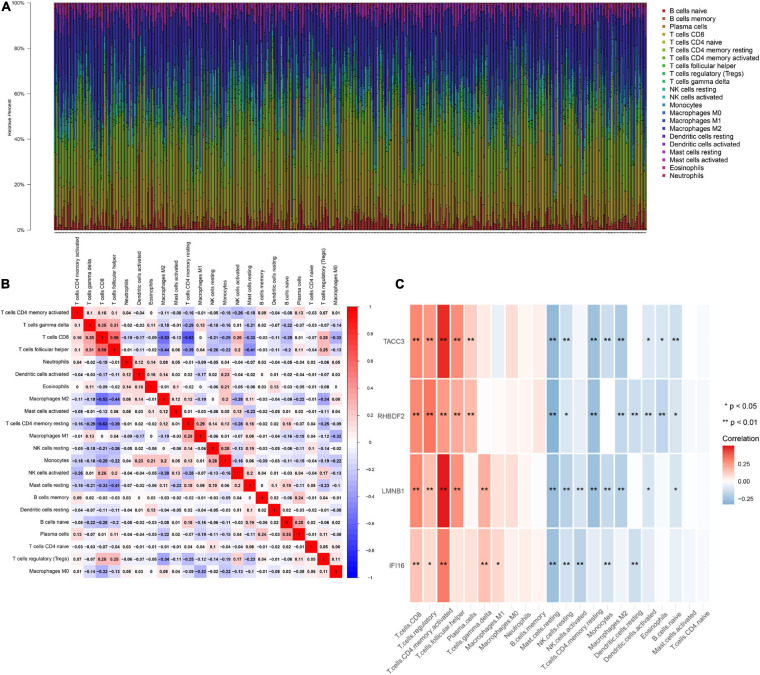
The landscape of immune infiltration in TCGA ccRCC patients. (A) The abundance fraction of 22 tumor-infiltrating lymphocytes (TILs) in the 396 ccRCC samples. Each column represents a sample, and each column with a different color and height indicates the abundance fraction of TILs in that sample. (B) The correlation between the abundance fractions of various immune cells. The value represents the correlation value. Red represents a positive correlation, and blue represents a negative correlation. (C) The relationship between expression of IFI16, LMNB1, RHBDF2 and TACC3 and various TILs.